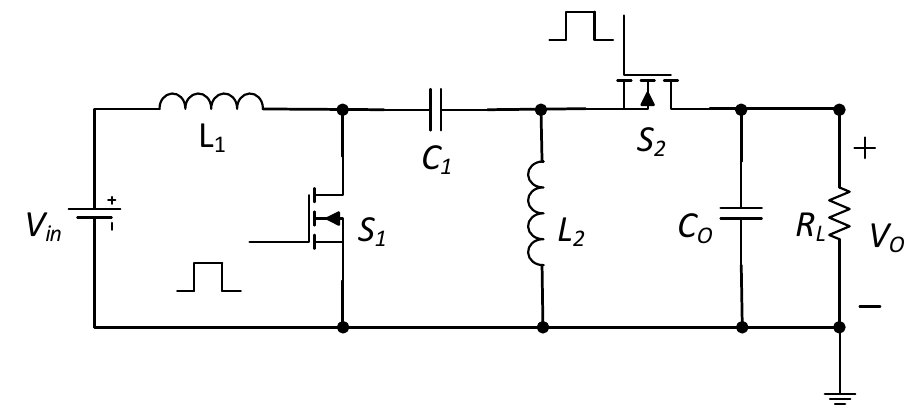
Figure 7. Schottky diode change to power switch.